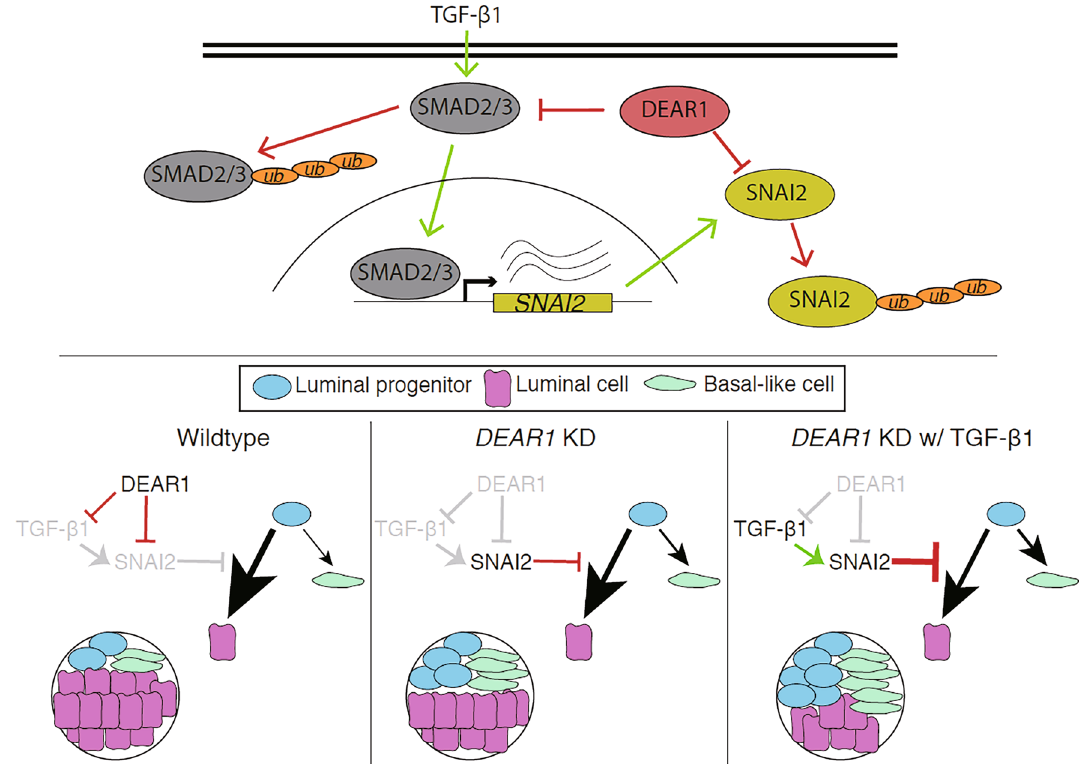
Figure 6. Simplified graphical model of DEAR1 regulation of luminal differentiation via TGF-β dependent and indepdendent mechanisms of SNAI2 inhibition. Top: DEAR1 inhibits SNAI2 (red pathway) by direct binding and uibiquitination, as well as by blocking SNAI2 transcription by binding and ubiquitinating upstream activator SMAD3 that is activated by TGF-β (green pathway). Bottom: Shifts in luminal differentiation dynamics or state occupancies (as depicted by arrow sizes, where larger size indicates higher likelihood) of luminal progenitors (blue), toward incomplete basal-like (green) or mature luminal cells (pink), depending on the presence (black) or absence (gray) of DEAR1,SNAI2, and TGF-β. The figure was created using Adobe Illustrator 2020 (Version 24.2.3), https:// www. adobe. com/ produ cts/ illus trator.